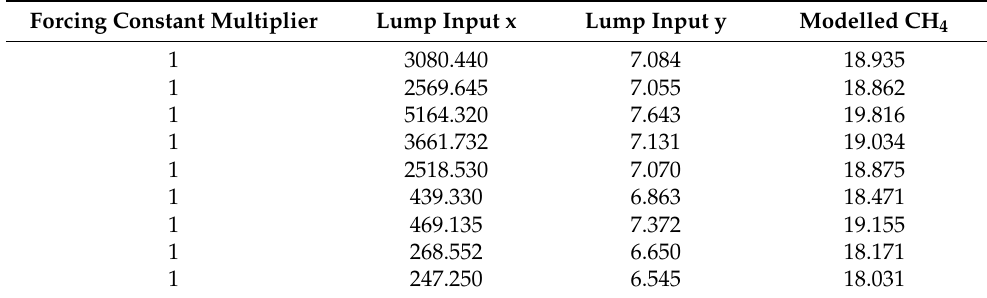
Table 5. Samples of lump input parameters from the test dataset and modeled methane for the biogas digester.